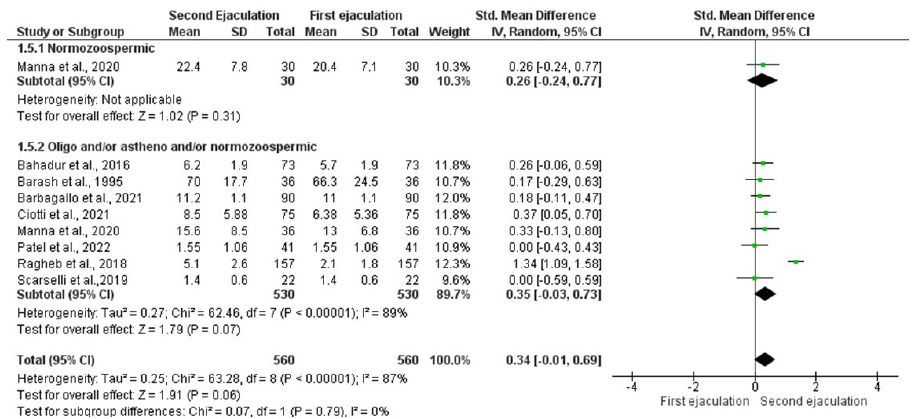
Figure 6. Forest plot of studies that evaluated the effects of a very short abstinence period on sperm morphology (expressed as a percentage). The following studies were included in the quantitative analysis (in order of appearance in the manuscript): Manna et al., 2020 [16], Bahadur et al., 2016 [17], Ragheb et al., 2018 [20], Ciotti et al., 2021 [22], Barash et al., 1995 [28], Sarselli et al., 2019 [33], Bar- bagallo et al., 2021